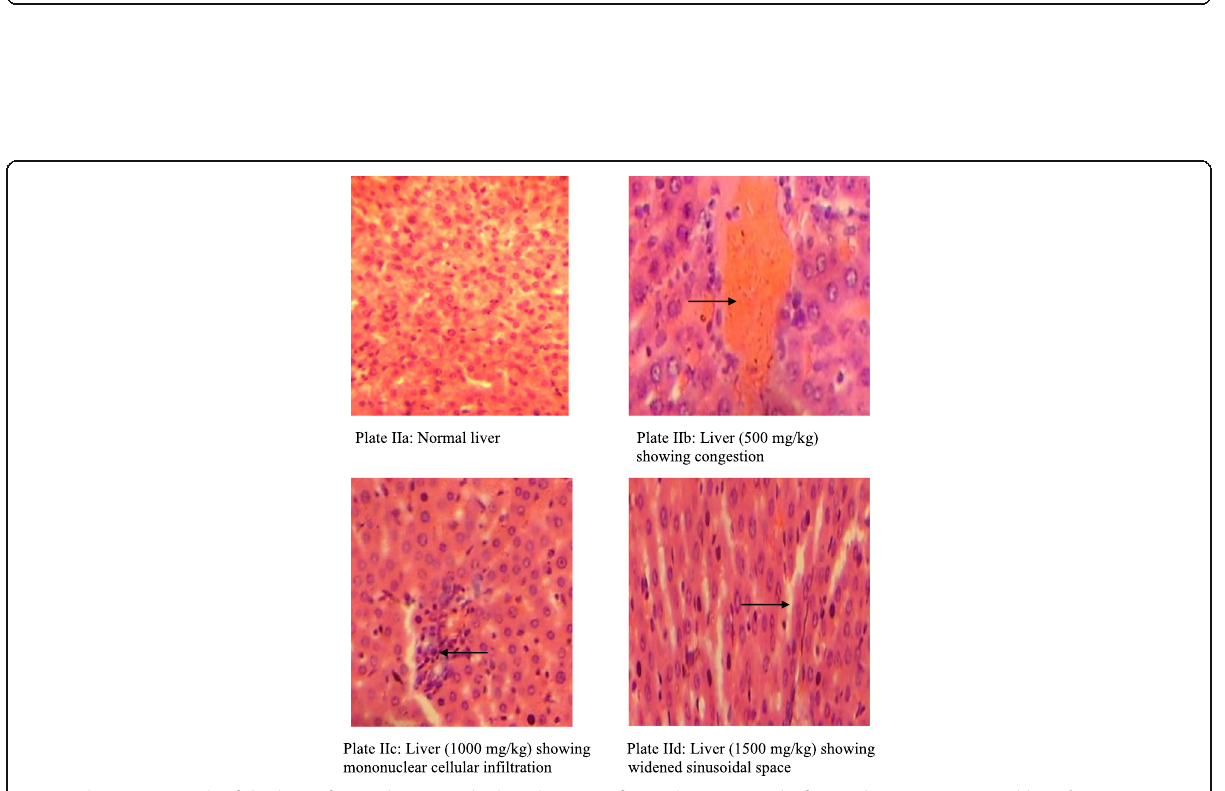
Fig. 2 Photomicrograph of the liver of rats administered ethanol extract of Spondias purpurea leaf (H and E × 200). a Normal liver. b Liver (500 mg/kg) showing congestion. c Liver (1000 mg/kg) showing mononuclear cellular infiltration. d Liver (1500 mg/kg) showing widened sinusoidal